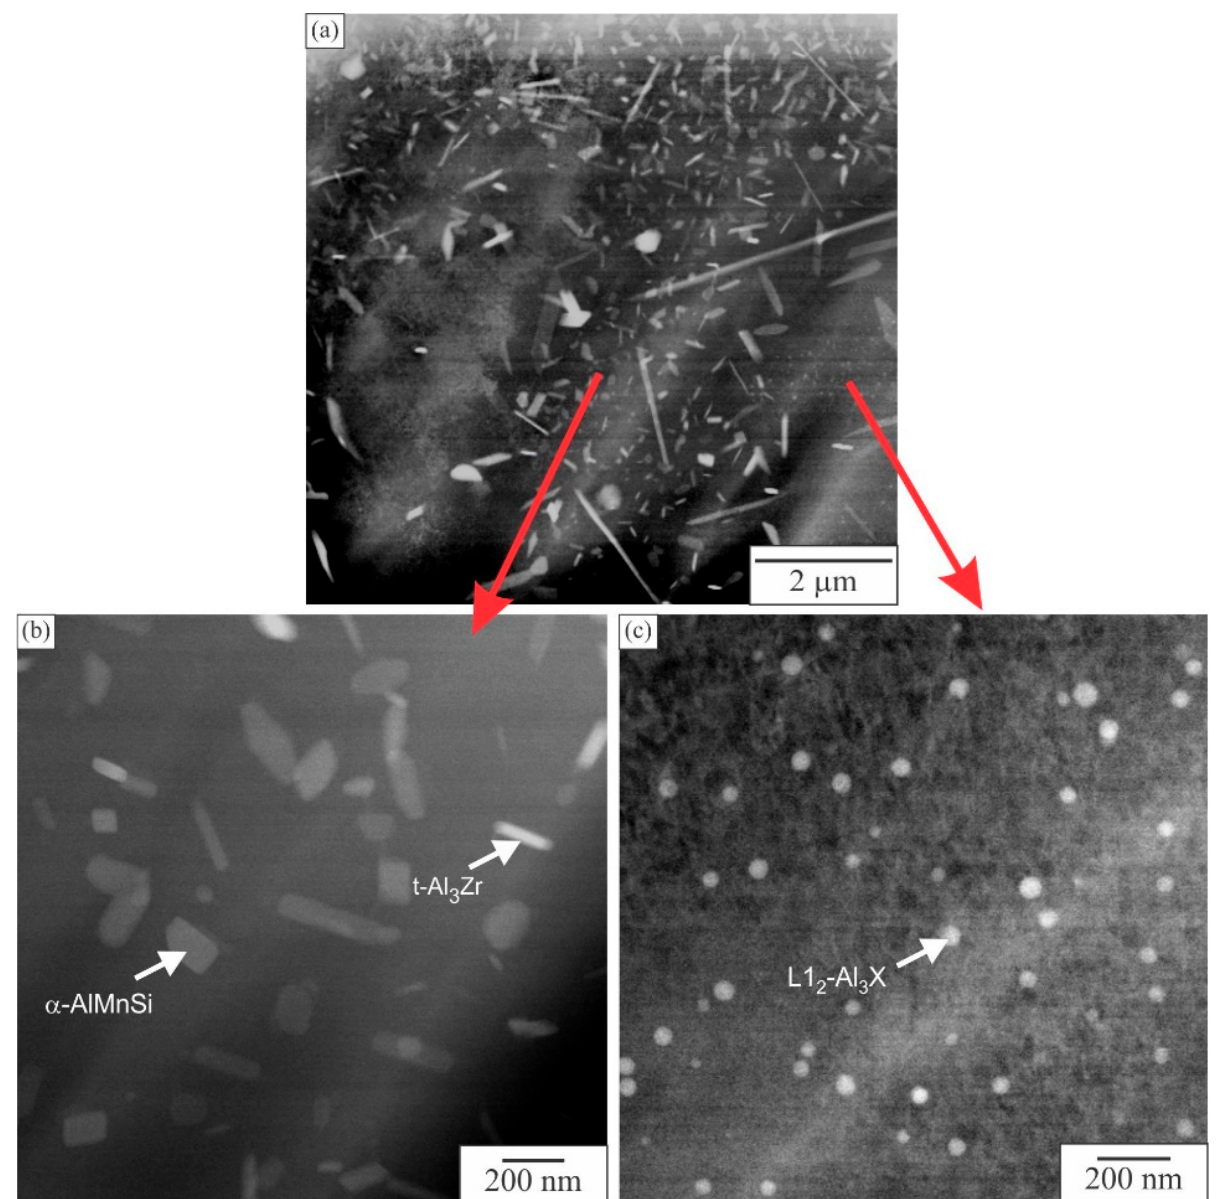
Figure 12. HAADF (high angle annular dark field) micrographs of the sample 6086-0.2Sc in the T6 temper. ( a ) A larger area, ( b ) the region with smaller dispersoids (t-Al 3 Zr and α -AlMnSi), and ( c ) in between the coarser plates (L1 2 -Al 3 X).